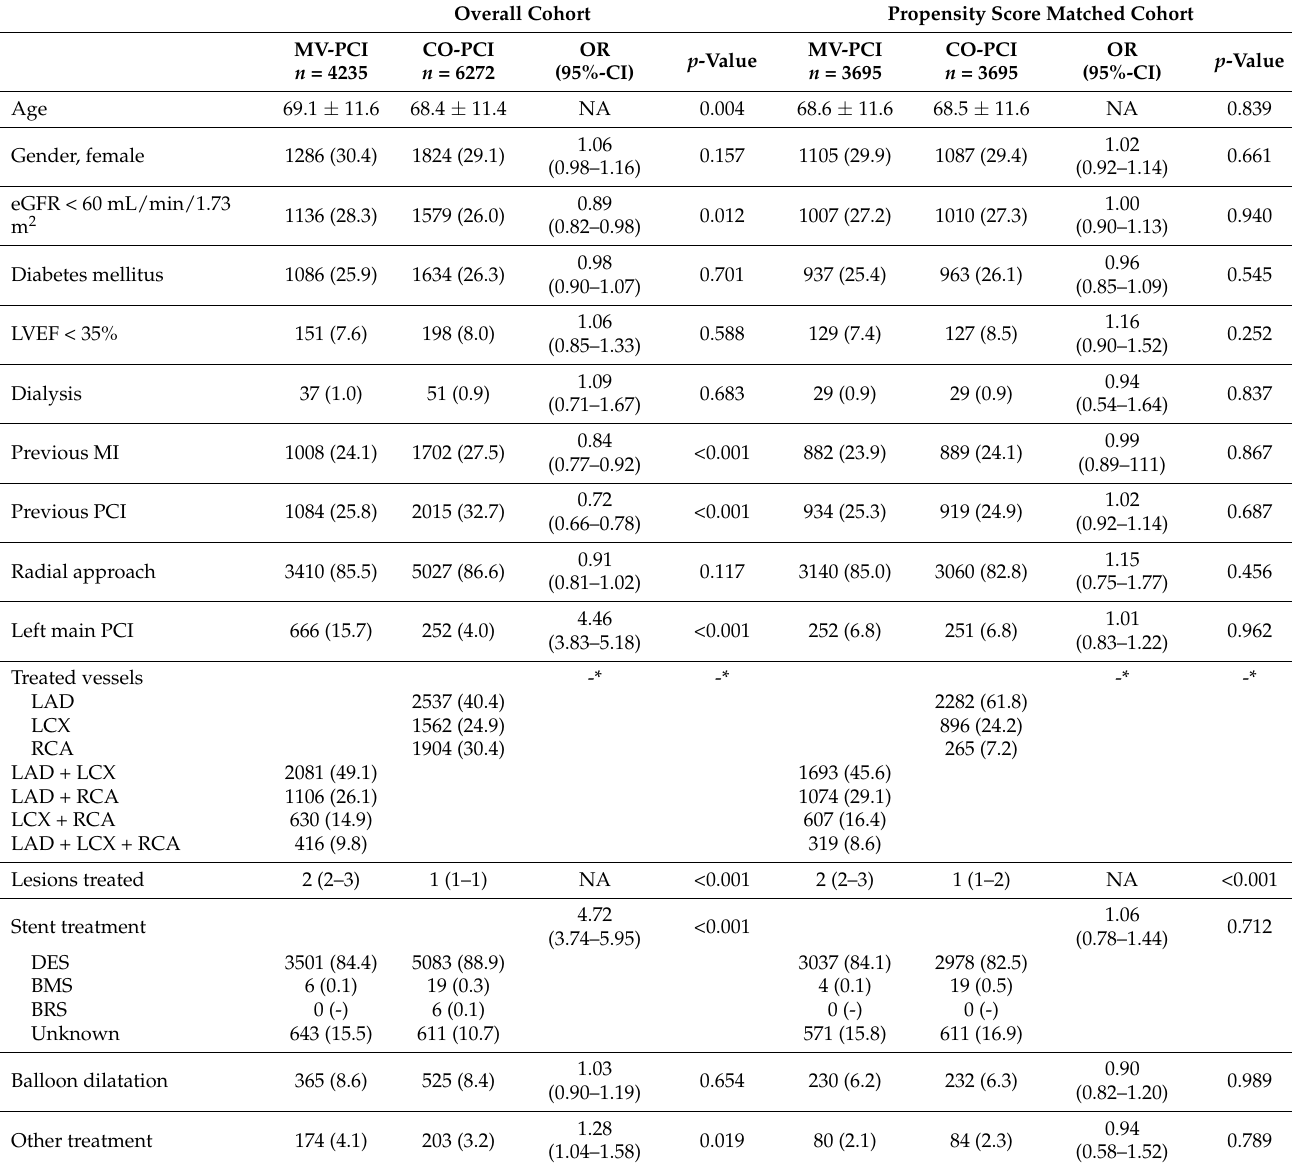
Table 1. Baseline